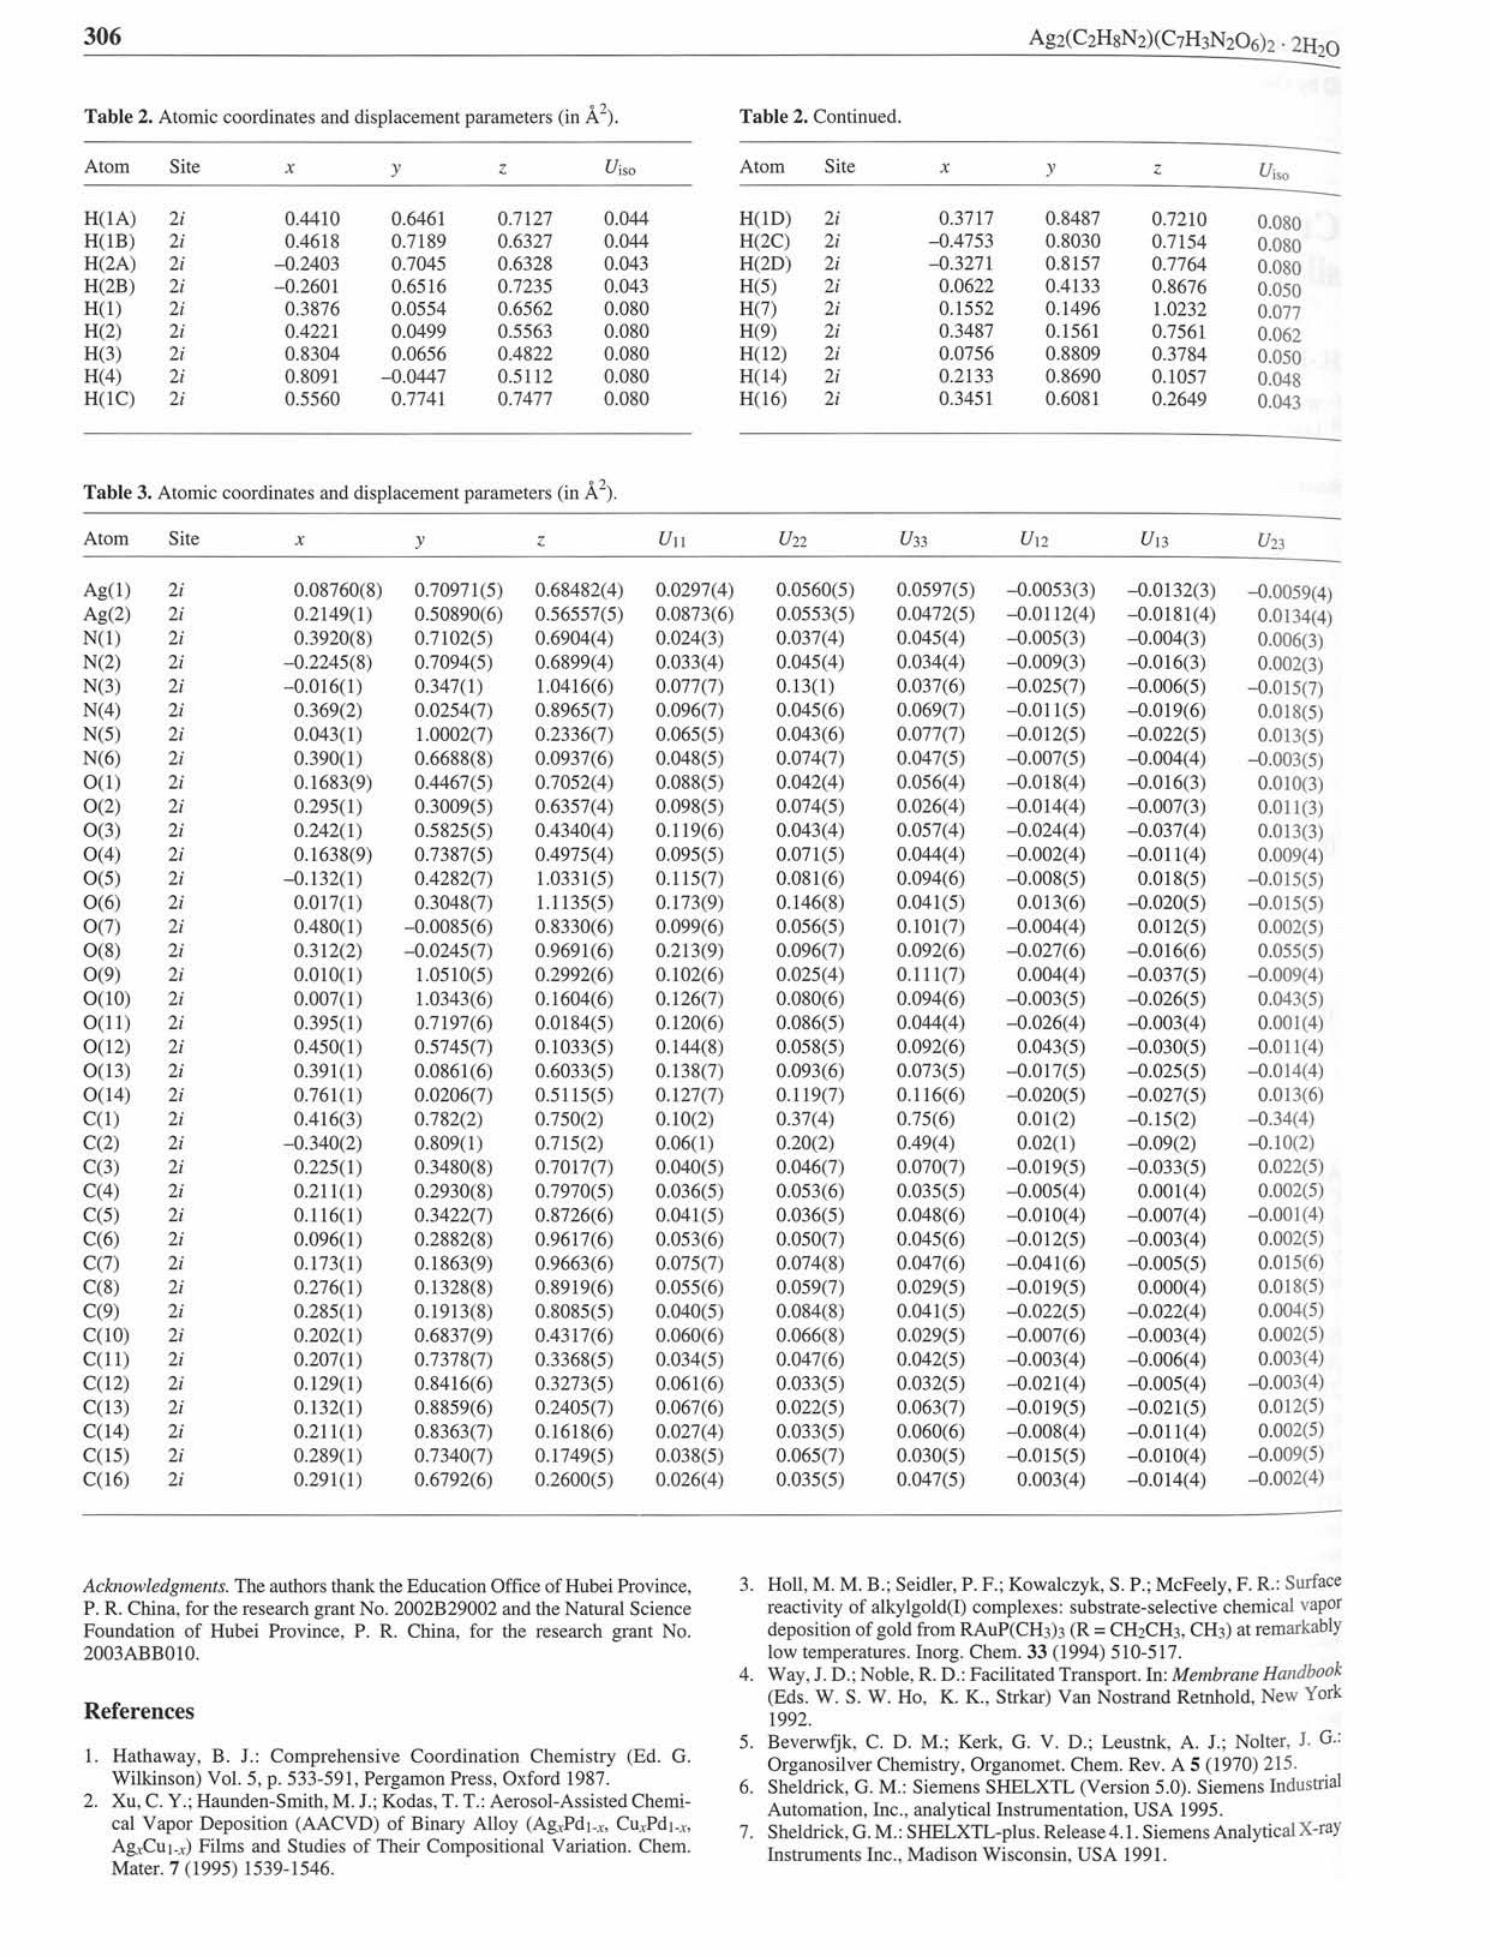
Table 3. Atomic coordinates and displacement parameters (in Â 2